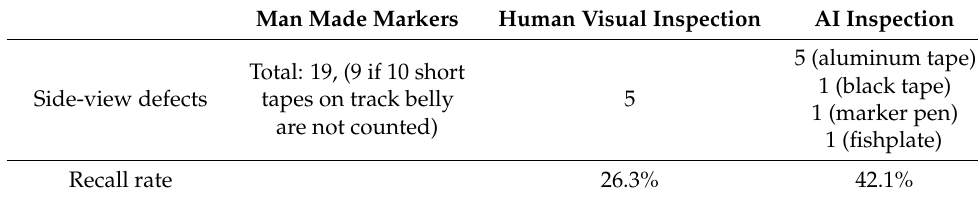
Table 21. Side-view defect inspection by AI and human.